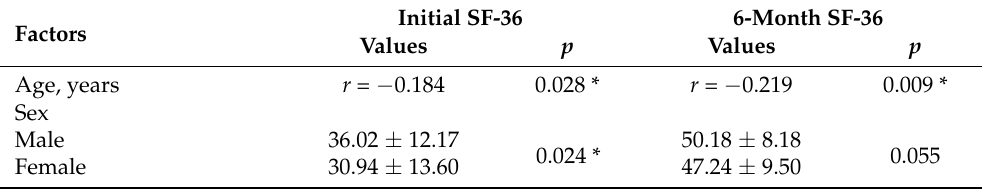
Table 4. Clinical factors associated with functional status. SF-36, short form 36; WBC, white blood cell; ESR, erythrocyte sedimentation ratio (normal range < 20 mm/h); CRP, C-reactive protein